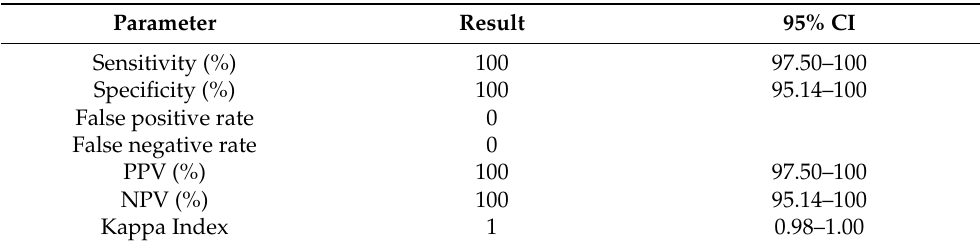
Table 4. Operational parameters of the test. PPV: Positive predictive value. NPV: Negative predic- tive value.